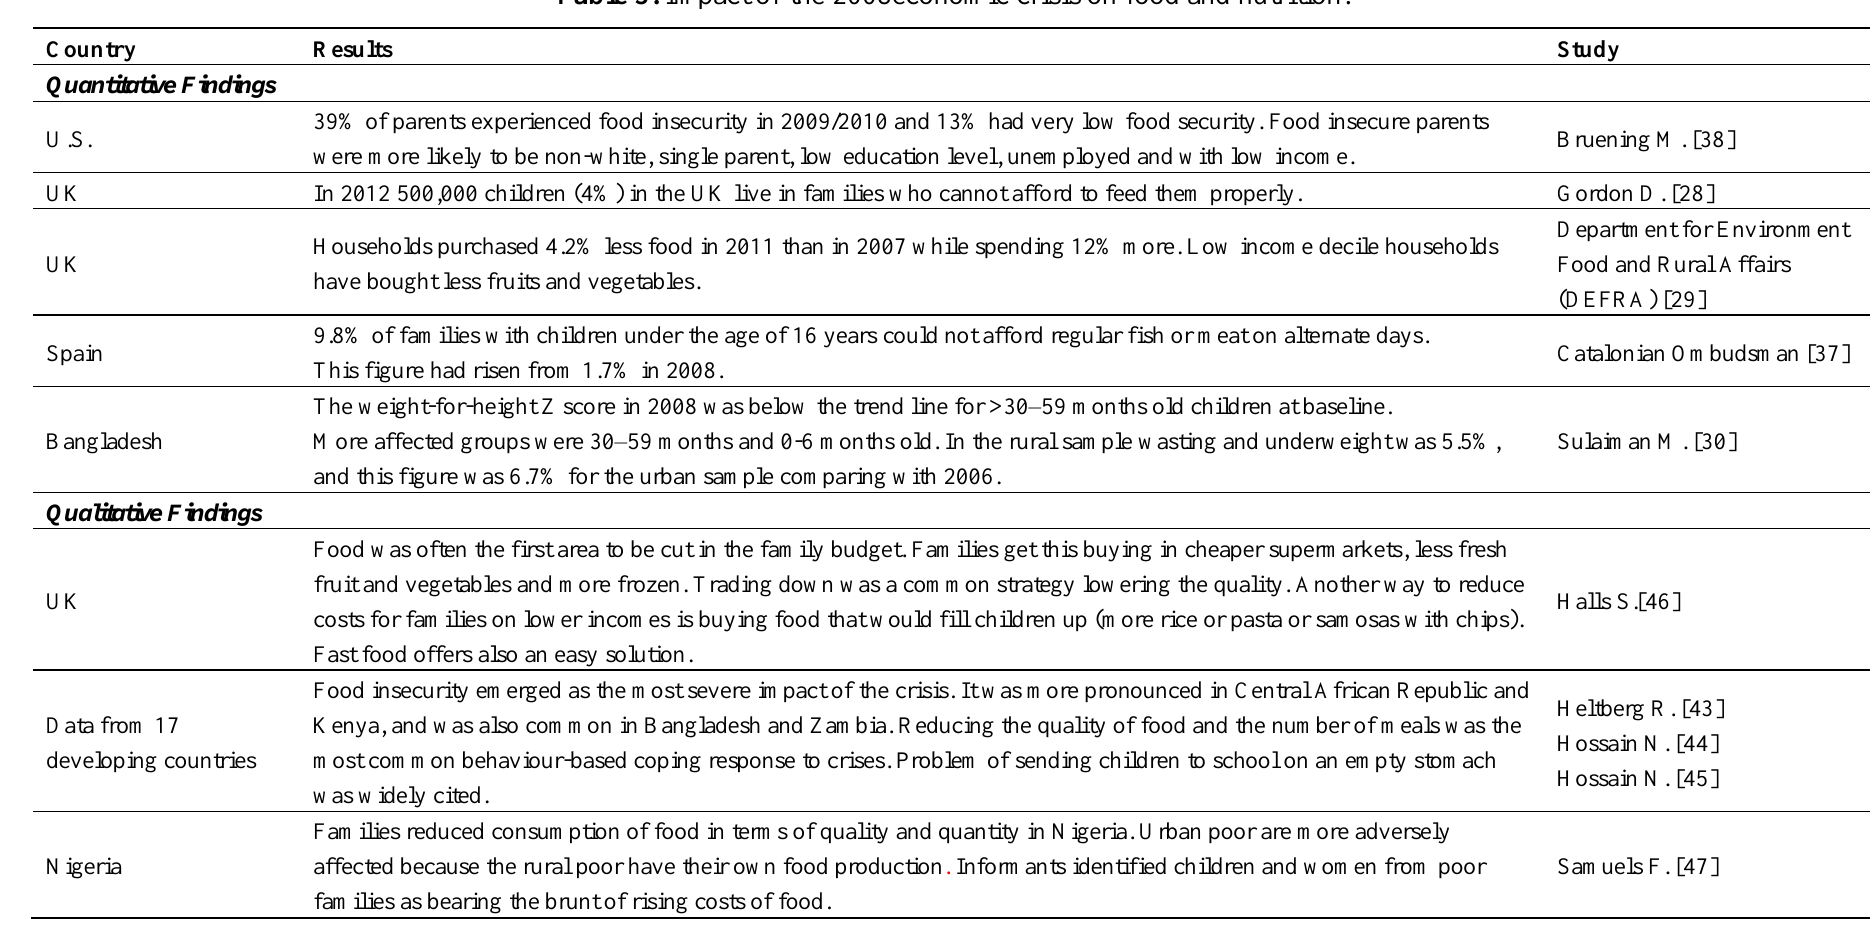
Table 3. Impact of the 2008economic crisis on food and